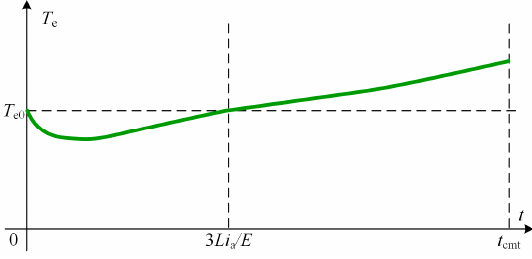
Figure 4. The e ff ect of back-EMF variation on the torque during the commutation Figure 4. The effect of back-EMF variation on the torque during the commutation process.